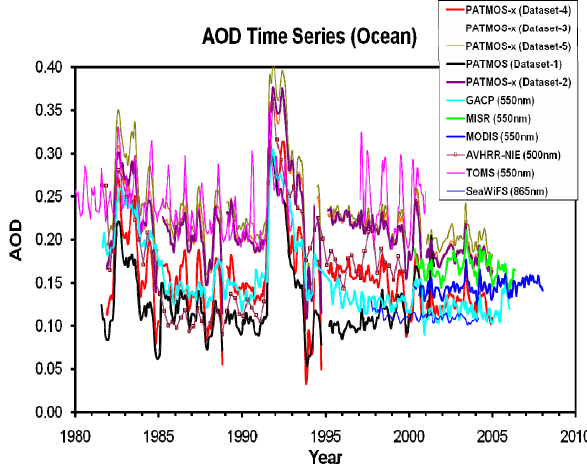
Figure 3. Comparison of global mean AOD computed from five versions of PATMOS experimental products, with reference to the other aerosol products discussed in the paper.